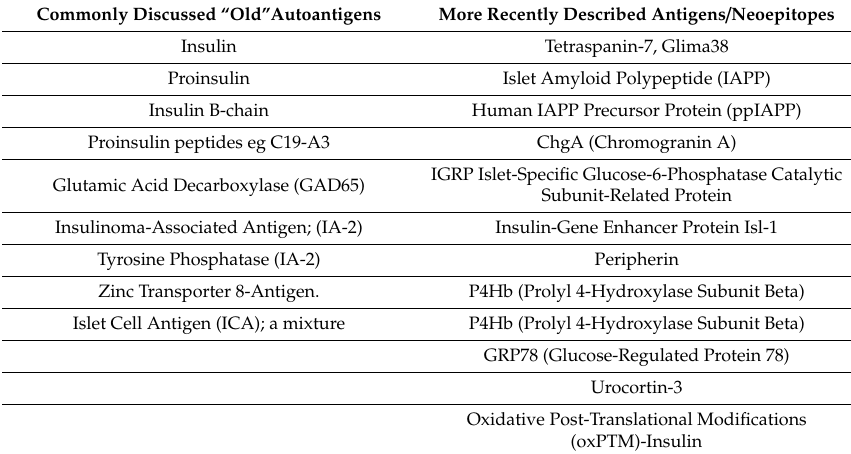
Table 1. Beta-cell-related autoantigens in type 1